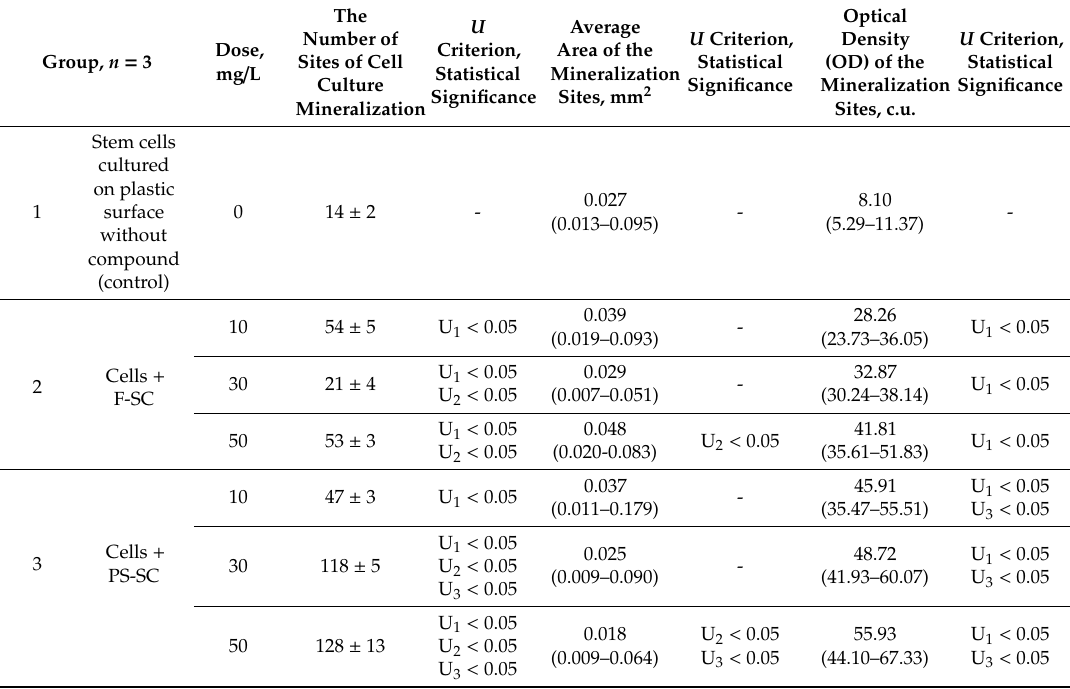
Table 2. In vitro e ff ect of tested compounds on hAMMSC osteogenic di ff erentiation with mineralization of cell culture matrix, X ± SD, Me